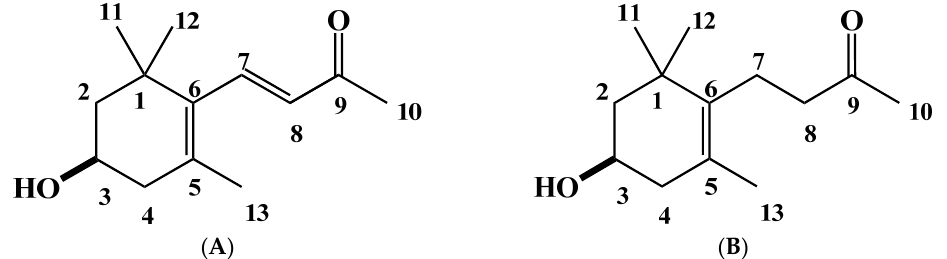
Figure 3. The chemical structures of the characterized allelopathic substances from Polygonum chinense extracts of Compound 1 , ( − )-3-hydroxy- β -ionone ( A ) and Compound 2, ( − )-3-hydroxy-7,8-dihydro- β -ionone ( B ).